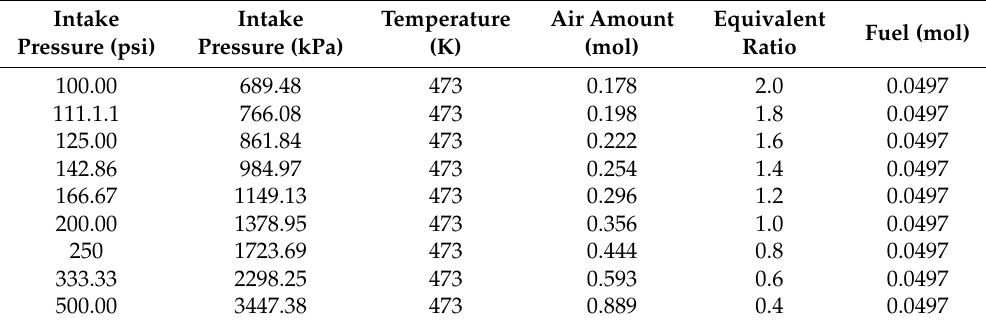
Table 4. Methanol constant fuel test data.